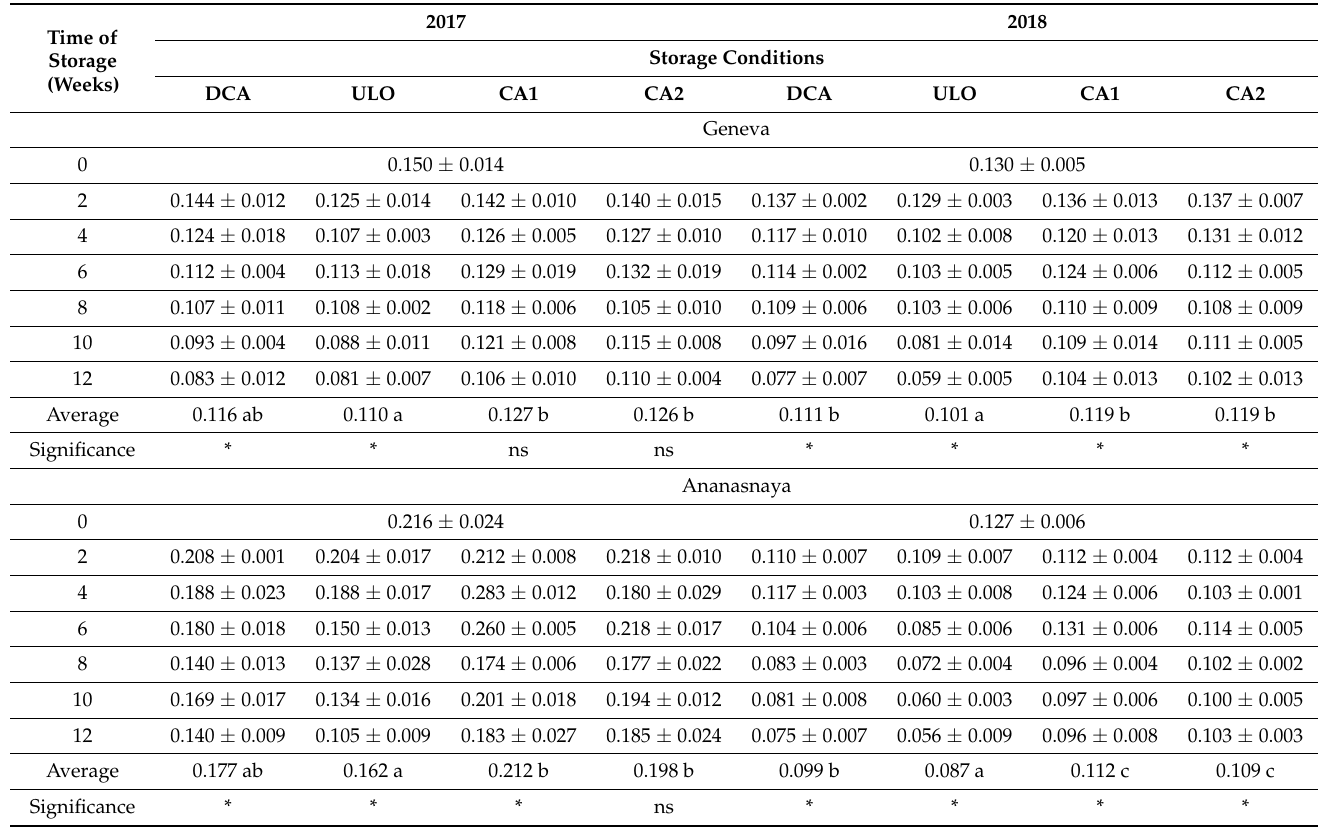
Table 8. Changes in malic acid content (g · 100 g − 1 F.W.) measured in ‘Geneva’ and ‘Ananasnaya’ minikiwi fruits in the postharvest period.